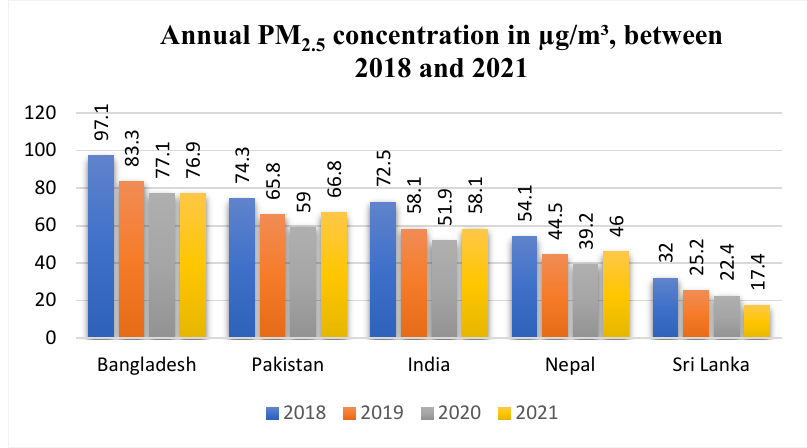
Figure 4. Annual means of PM 2.5 concentrations, depicted from 2018 to 2021 in µg/m 3 [17]. Data were unavailable for Bhutan.